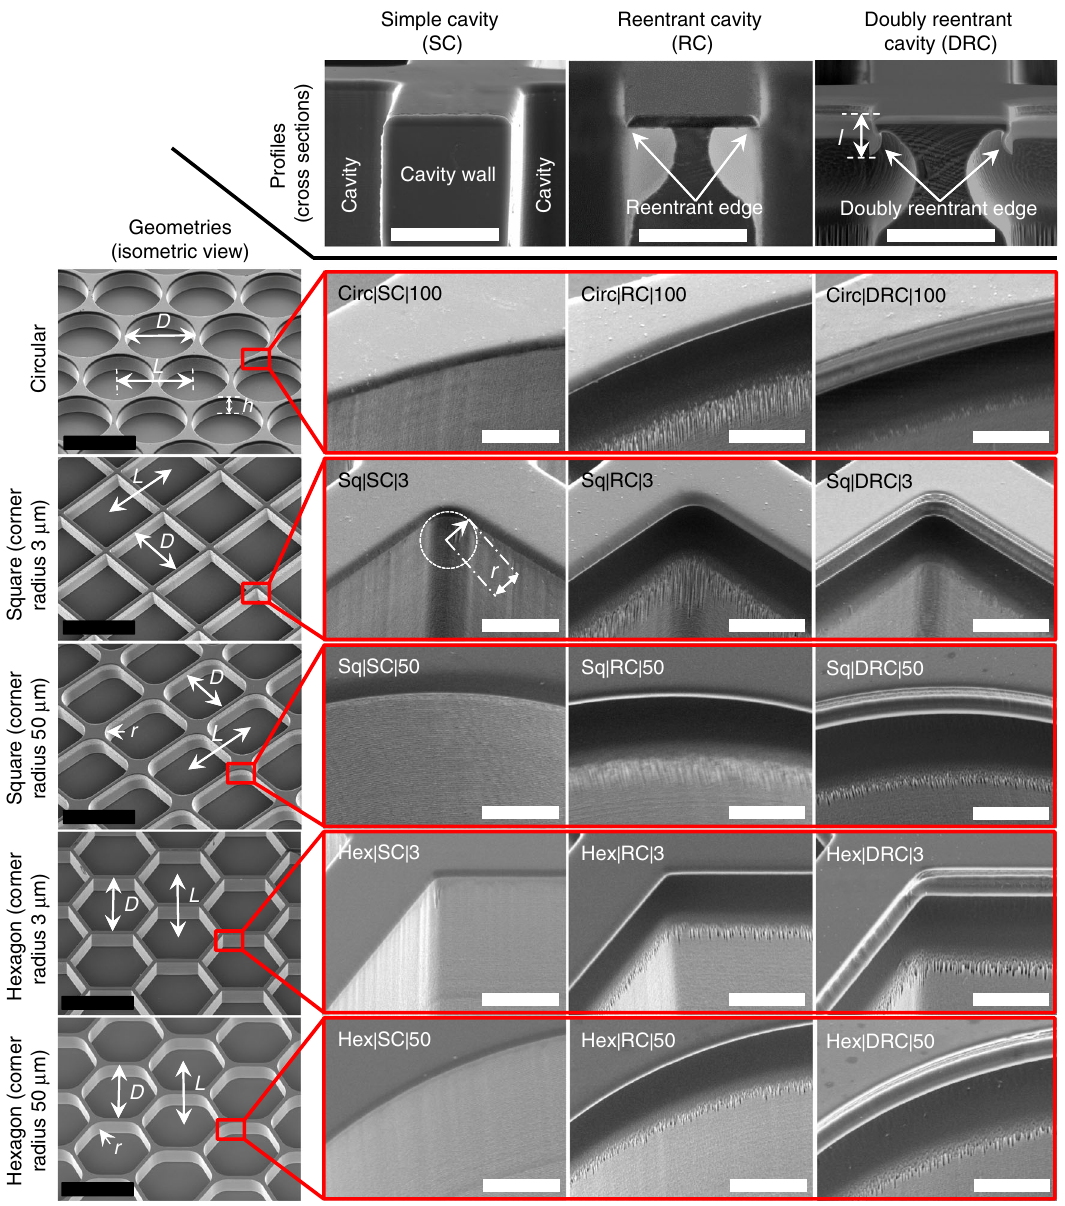
Fig. 1 Scanning electron micrographs of fi fteen types of microtextures investigated in this work. The cavities were classi fi ed based on their pro fi les as simple cavities (SCs), reentrant cavities (RCs), and doubly reentrant cavities (DRCs). Further, for each pro fi le, circular, square, and hexagonal shapes were tested. The square and hexagonal shapes were further classi fi ed based on the sharpness of the corners. Scale bars: (i) Solid black line refers to 200 µ m, and (ii) White line refers to 10 µ